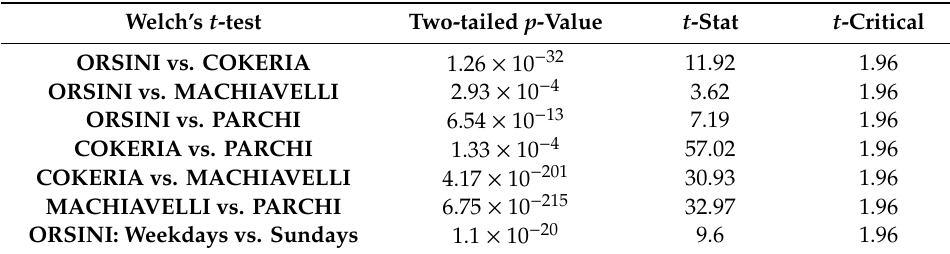
Figure 3. Annual average concentration and standard deviation of total p ‐ PAH concentrations at the Orsini, Cokeria, Machiavelli and Parchi sites from August 2013 to August 2014. Table 1. Welch’s t -test Table 1. Welch’s t ‐ test results.